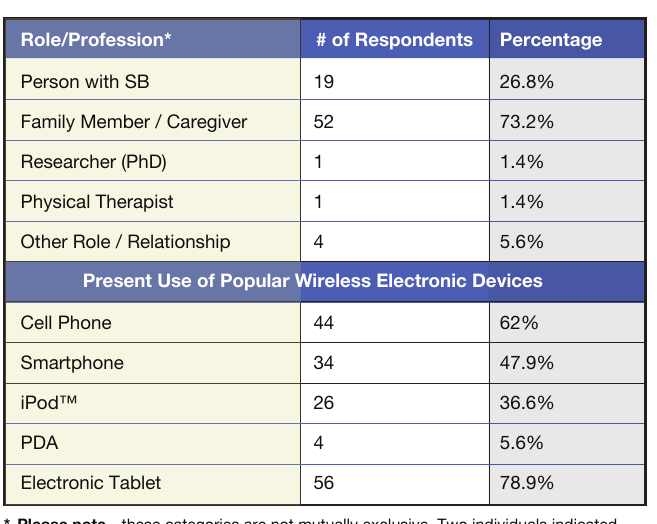
Table 3: Demographic Descriptive Statistics of Persons with SB, Family Members & Caregivers (N =